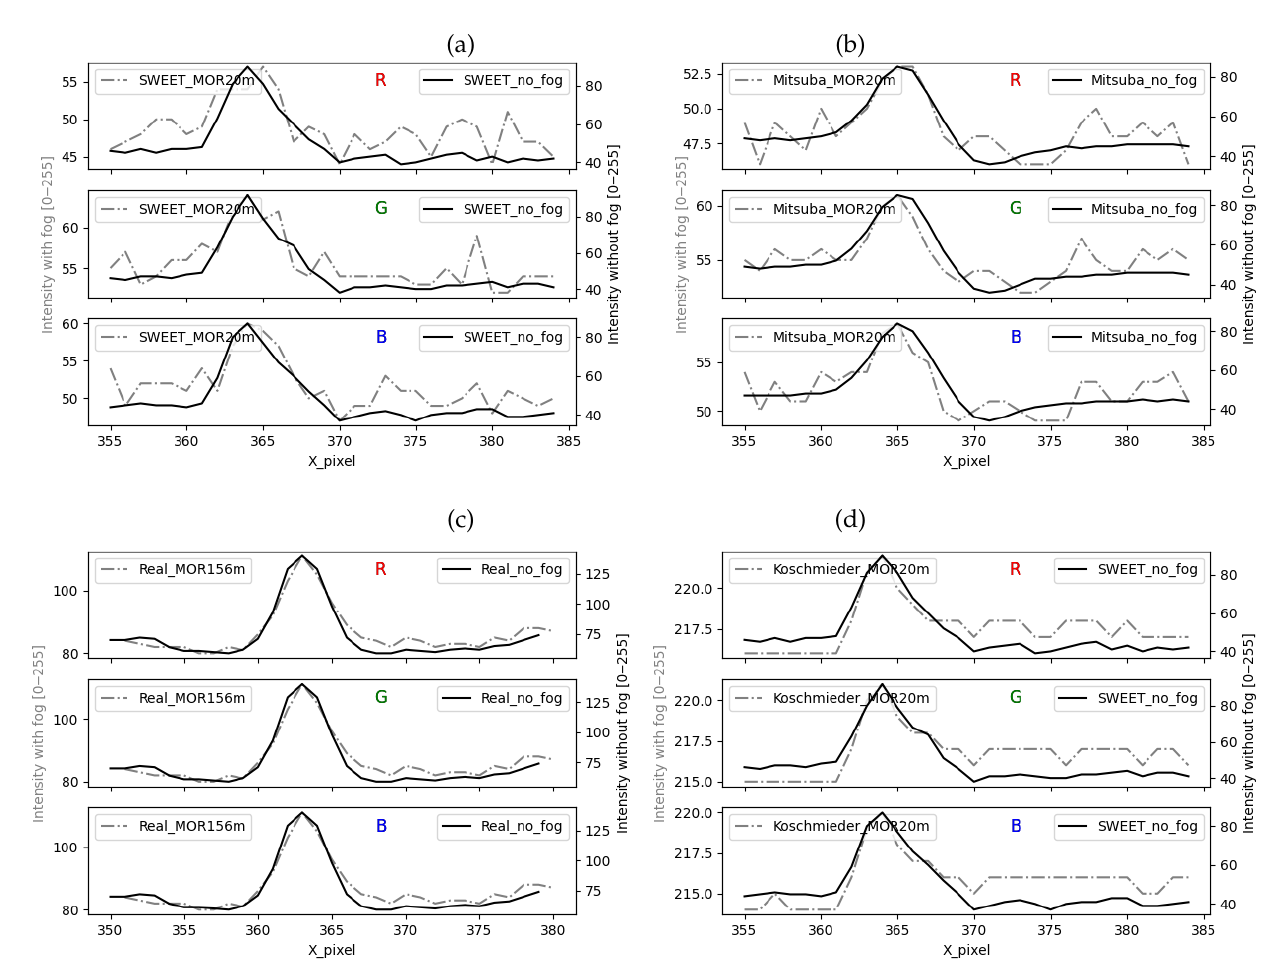
Figure 13. Comparing the intensity of a pixel line for images coming from SWEET ( a ), Mitsuba ( b ), real camera images ( c ) and Koschmieder ( d ), rescaled